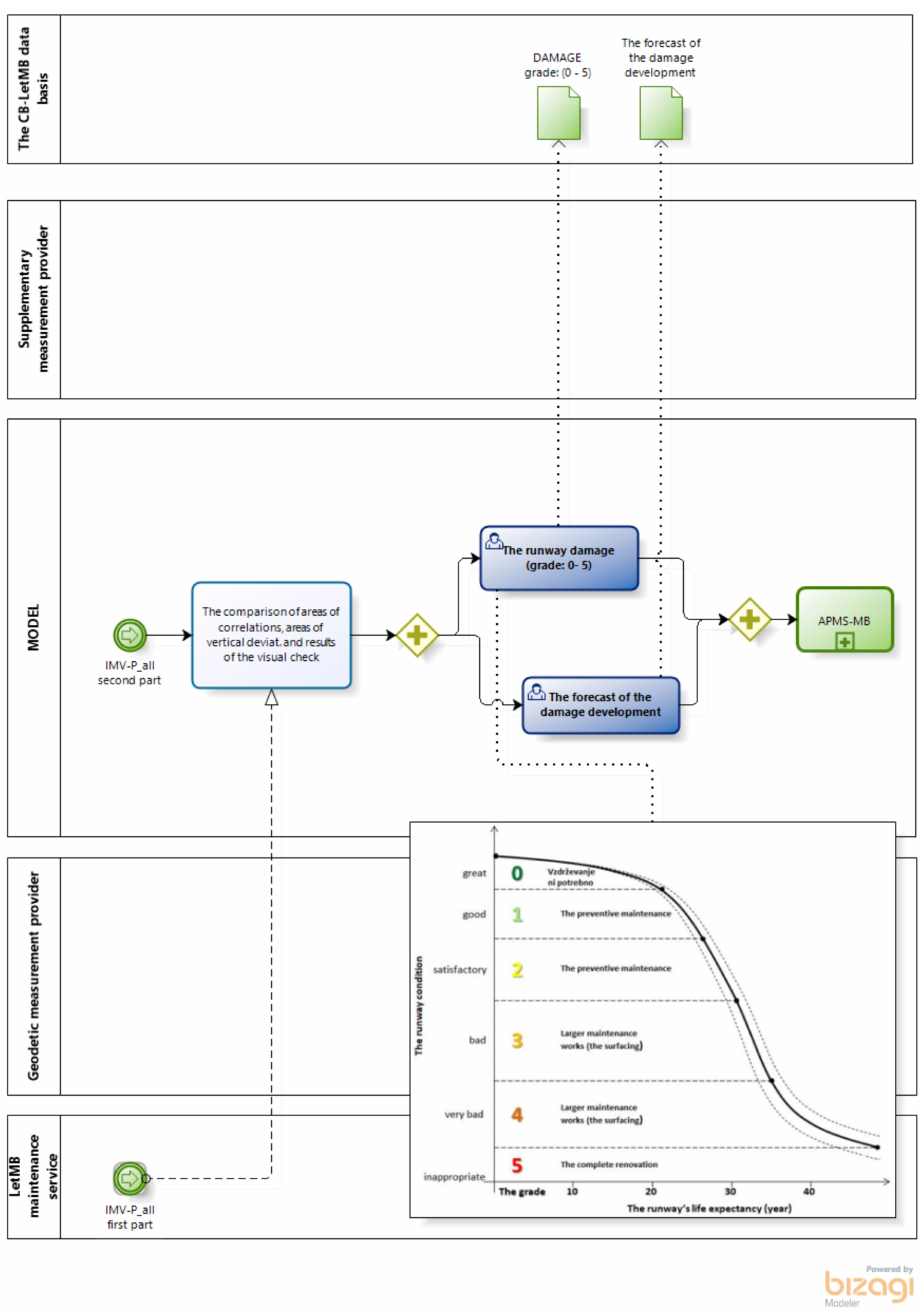
Figure 5. The monitoring process model, sub-process IMV-P_all, part